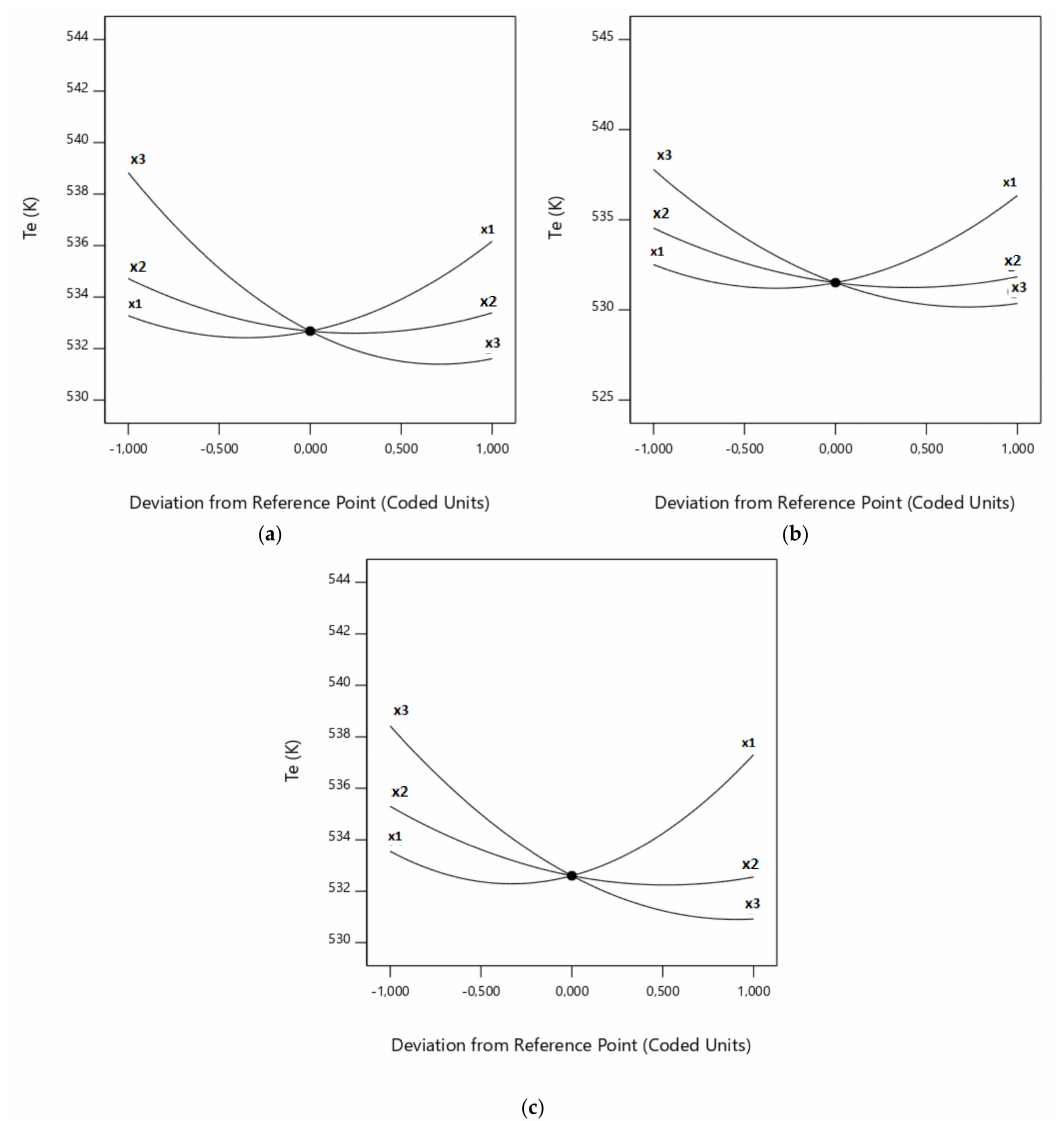
Figure 8. Influence of factors on T e : ( a ) Complete design; ( b ) Central composite design; and ( c ) Box–Behnken